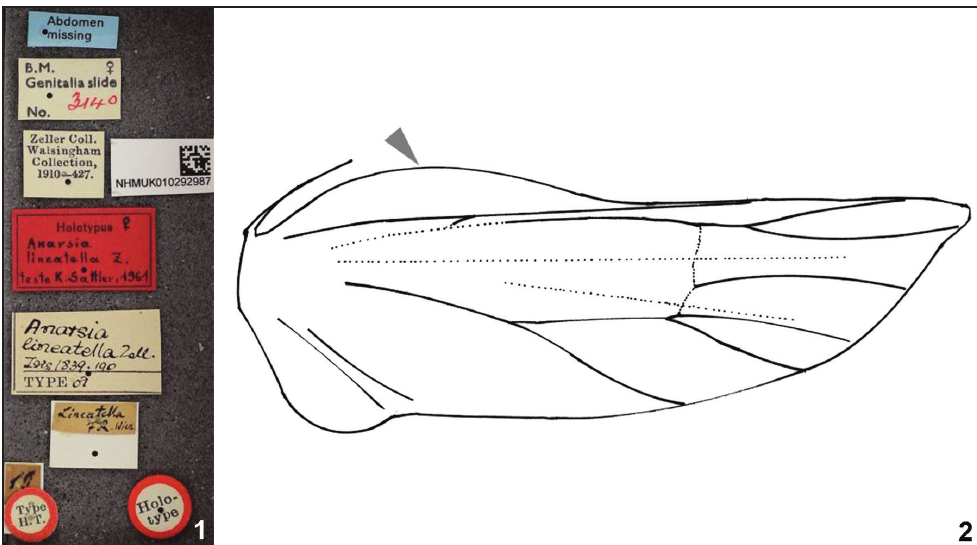
Figures 1, 2. 1. Anarsia lineatella , holotype, labels (foto D. Lees, by courtesy of the BMNH). 2. Anarsia innoxiella sp. n., hindwing with convex extension at proximal part of costa